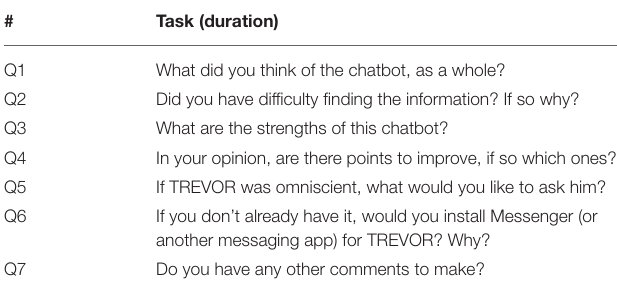
TABLE 2 | Debriefing